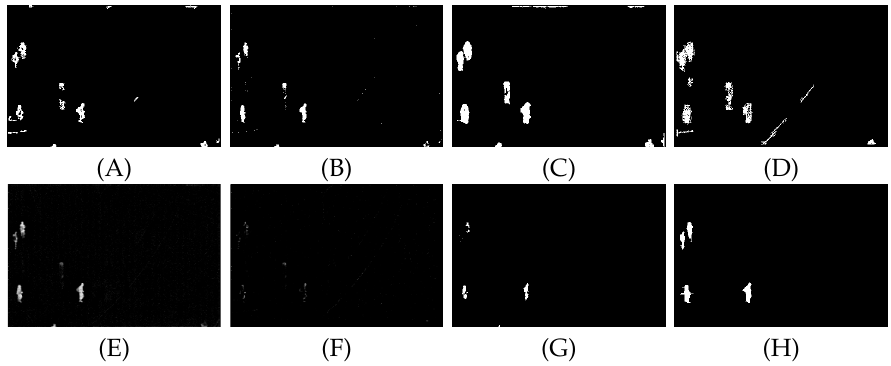
Figure A8. ( A – H ) shows the detection results of eight algorithms PSTNN, TV-PCP, VNTFR, anisotropy, ASTTV, SRWS, RPCA and propose method, respectively, under sequence